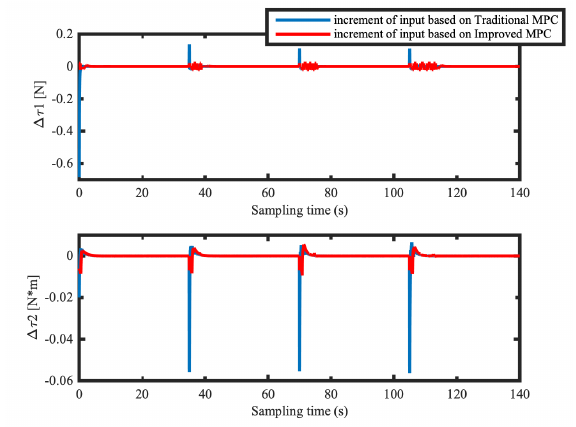
Figure 14. The comparison of control increment in square